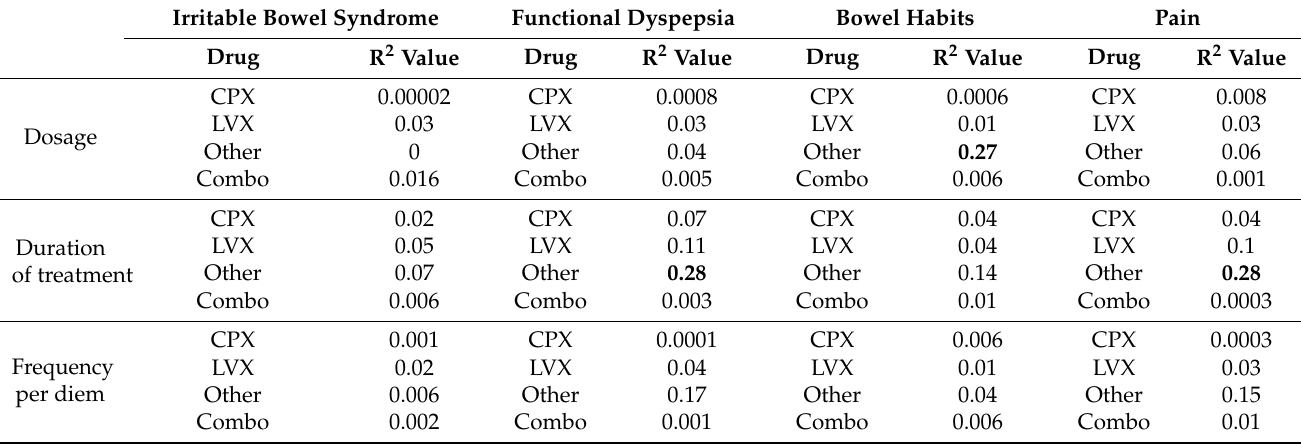
Table 4. Summary of the R 2 correlation values for linear regressions calculated to compare the relationship between the diagnostic a priori scores and dosage, duration of treatment, and frequency per diem with ciprofloxacin (n = 154), levofloxacin (n = 69), other FQs (n = 21) and a combination of two or more FQs (n = 61). Bolded values indicate a slight, positive correlation between the two values analyzed; p <